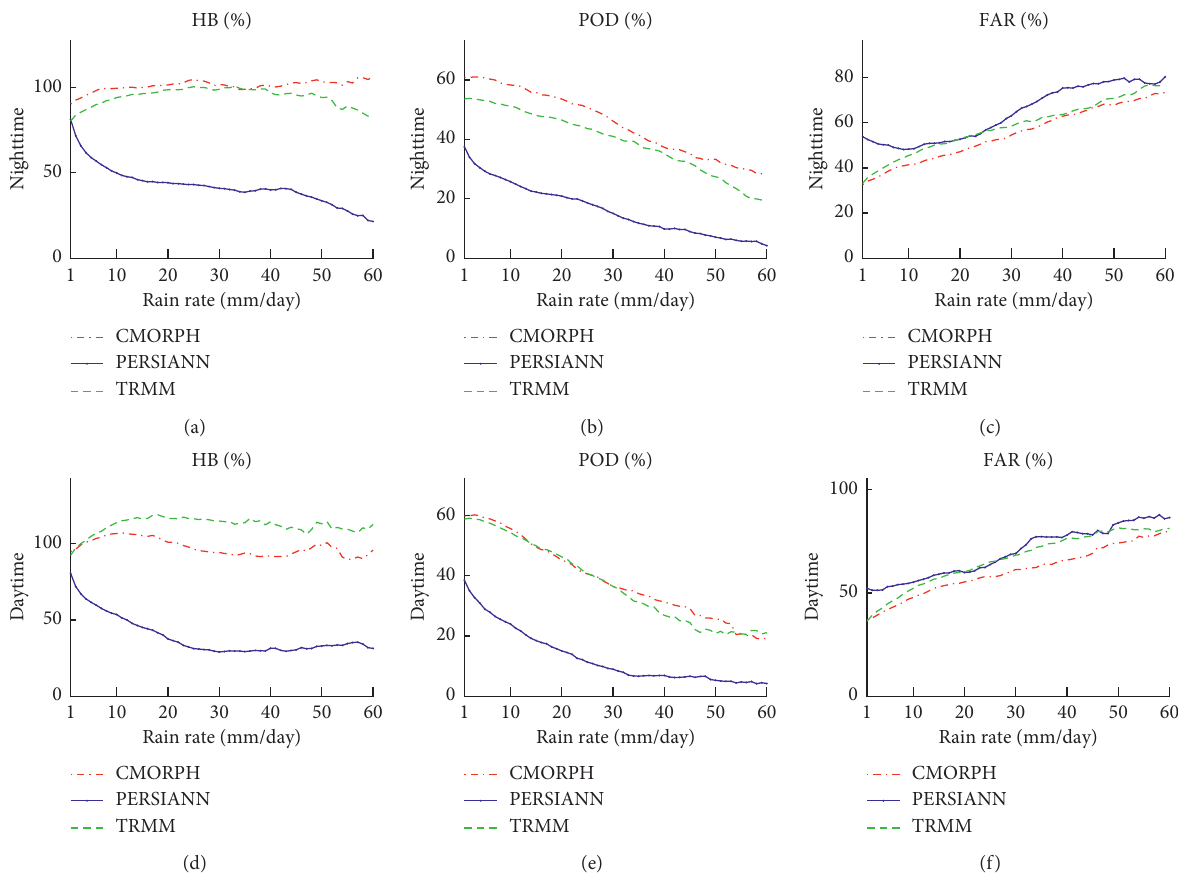
Figure 8: (a) The hit bias, (b) the probability of detection, and (c) the false alarm rate of each satellite product at nighttime. (d) The hit bias, (e) the probability of detection, and (f) the false alarm rate of each satellite product at